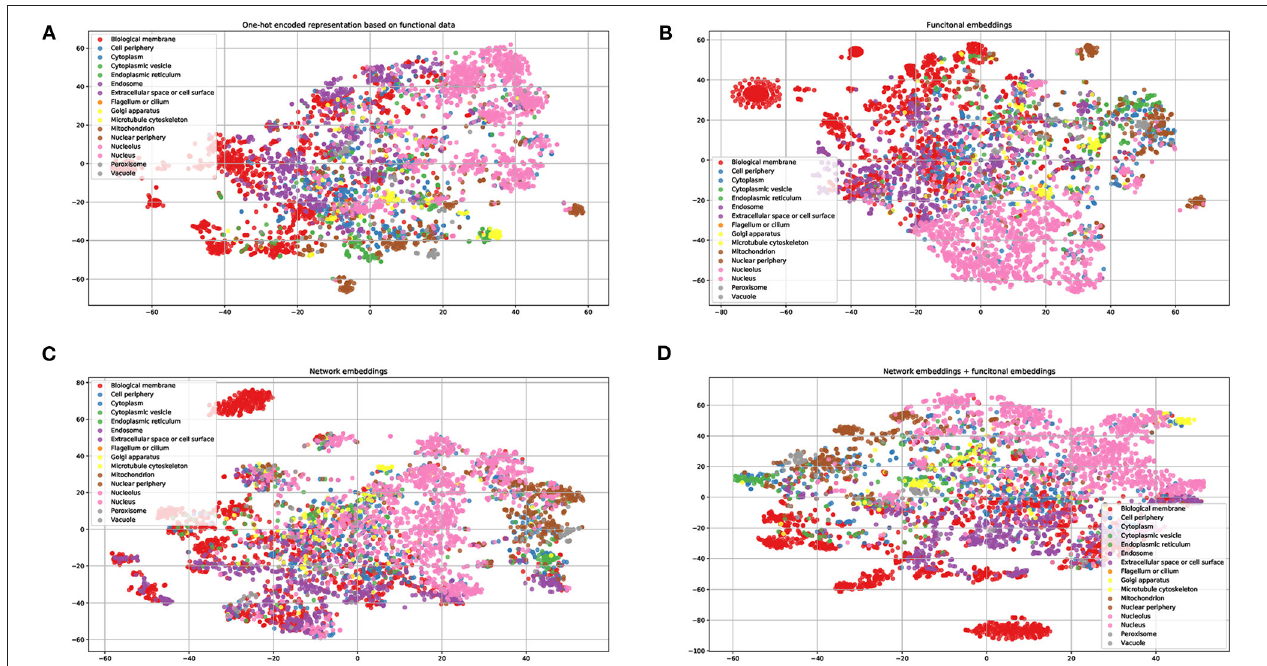
FIGURE 2 | Visualization of one-hot encoded functional features and the learned embeddings. (A) One-hot encode representation of functional data KEGG/GO terms; (B) the learned network embeddings from a protein-protein network; (C) the learned embeddings of functional data using word2vec; (D) the combined network and functional